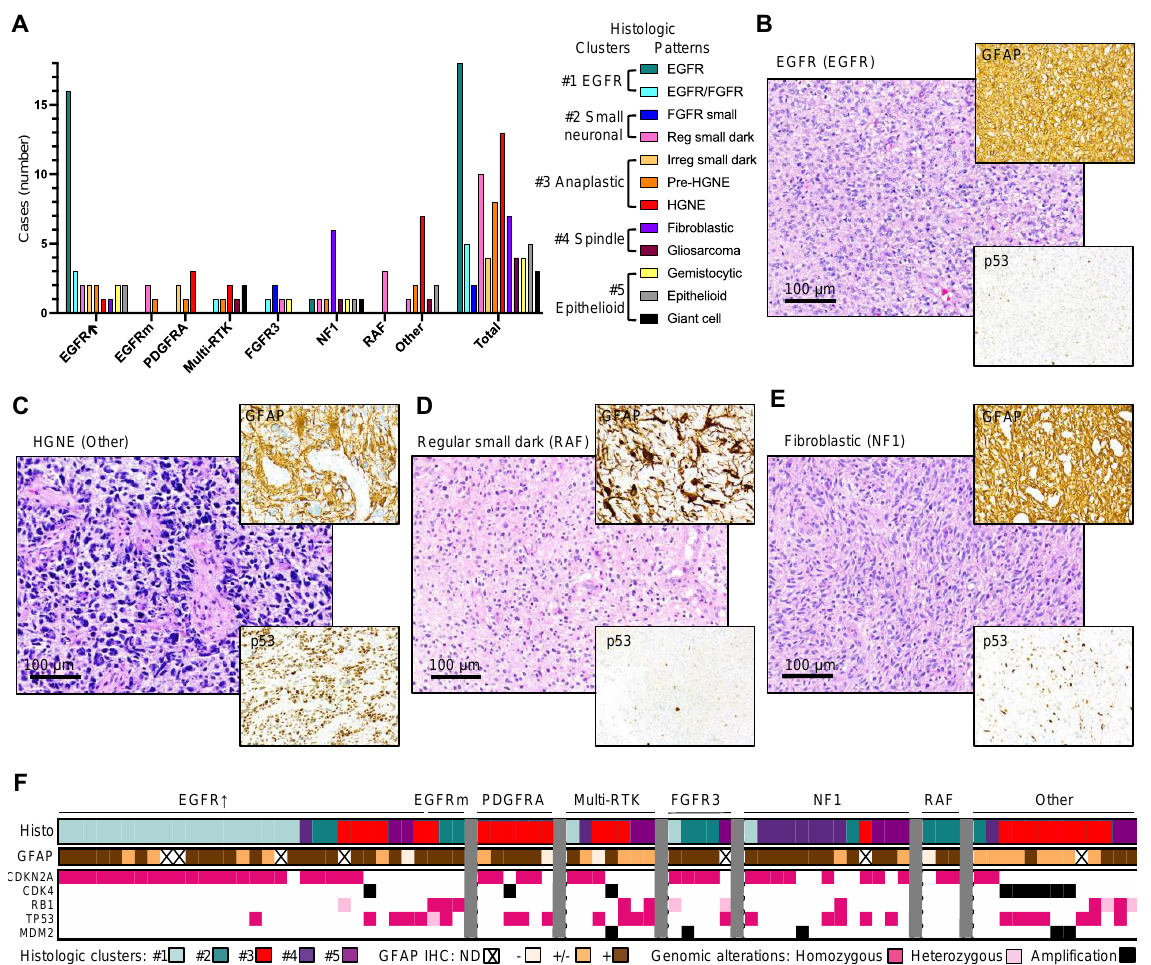
Figure 3. Histologic patterns and clusters in IDH-wild-type glioblastoma subgroups. ( A ) Bar graph showing histologic pattern distribution in the molecular glioblastoma subgroups and the total distribution in the cohort. Reg, regular nuclear contour; irreg, irregular nuclear contour; HGNE, high-grade neuroendocrine. ( B – E ) Representative H&E morphological appearances of the most common histological patterns. The molecular subgroup corresponding to the case is indicated in parenthesis. IHC with GFAP and p53 antibodies is shown in insets. ( F ) Histologic–molecular correlations. Histologic cluster distribution in individual cases from the IDH-wild-type glioblastoma subgroups shown in association with cell cycle G1 phase and p53 pathway mutations. The five histologic clusters (histo) are illustrated in ( A ).